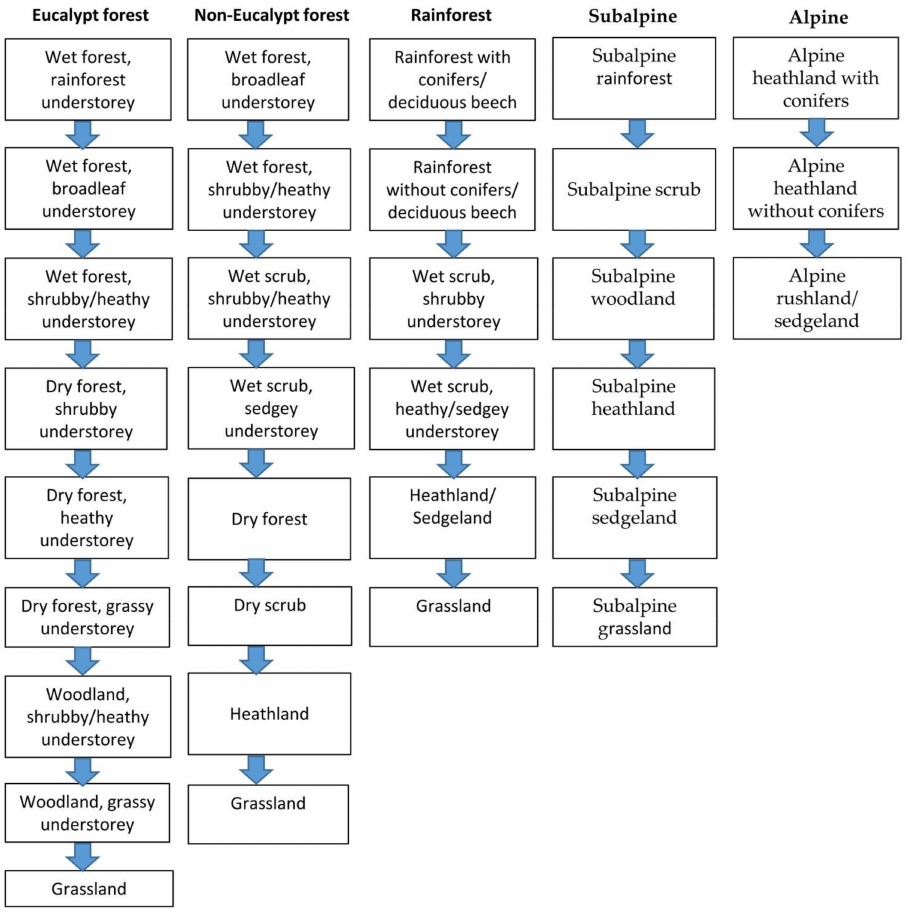
Figure 1. The vegetation pathways followed in the model. Detailed steps with the associated TASVEG 3.0 vegetation codes representing the original vegetation types used to develop the pathway are shown in Supplementary Material Table